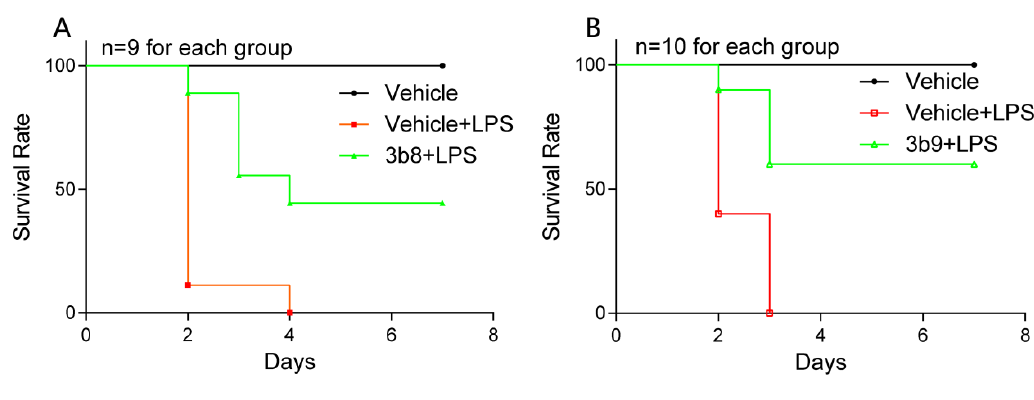
Figure 6. Compounds 3b8 and 3b9 improve survival of mice subjected to a lethal dose of LPS. Mice were intraperitoneal injected with 10 mg/kg 3b8 or 3b9 15 min before the injection of LPS 25 mg/kg). Survival rates were recorded for 7 days after the LPS injection at the interval of 1